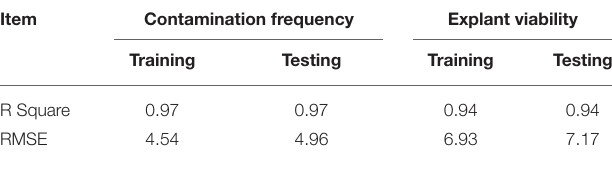
TABLE 7 | Statistics of MLP models for contamination frequency (CF) and explant viability (EV) of chrysanthemum (training vs. testing values).